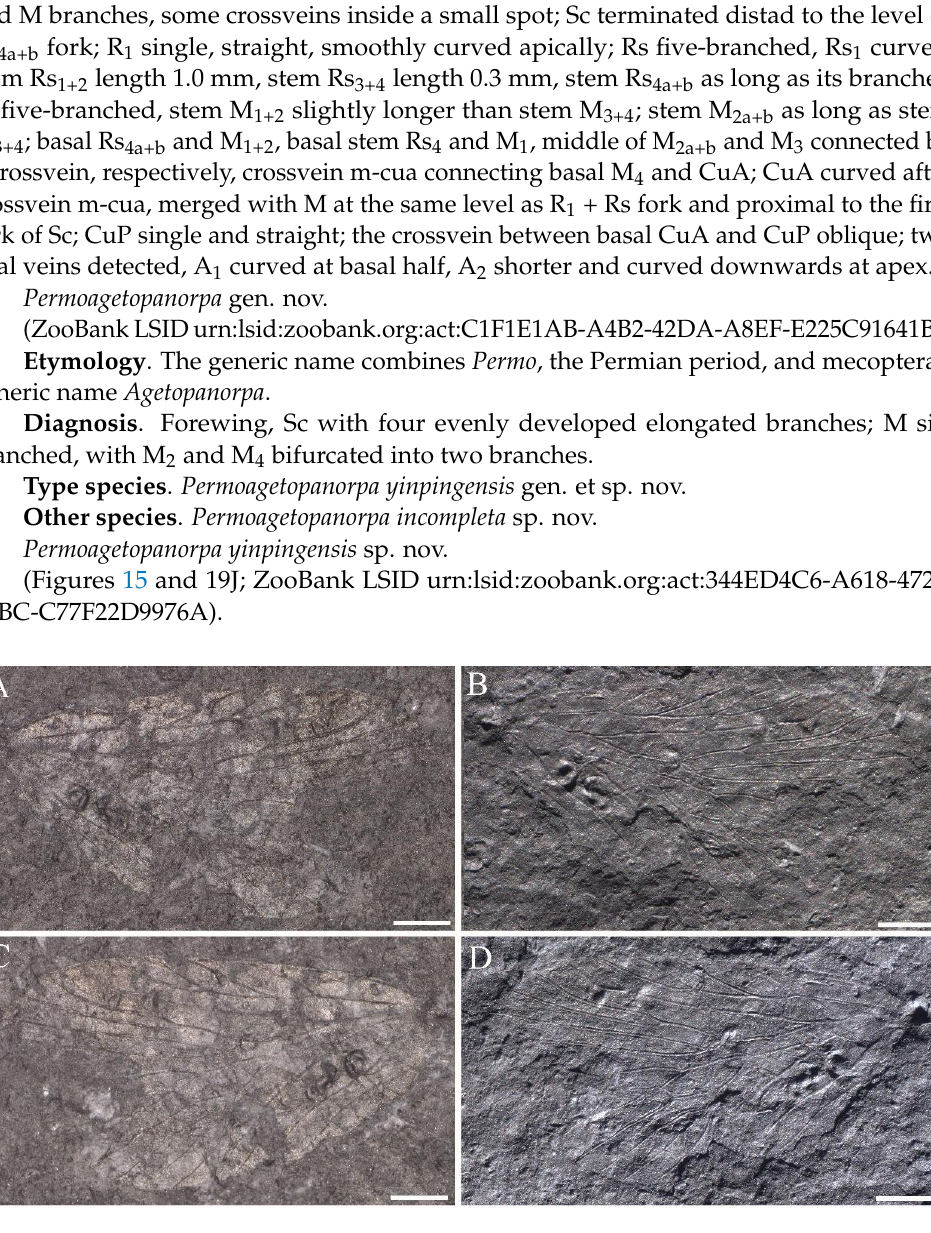
Figure 15. Permoagetopanorpa yinpingensis gen. et sp. nov., NIGP200928 (holotype). ( A , B ) Photographs of part; ( C , D ) Photographs of counterpart; ( A , C ) were taken when specimens were immersed under 70% alcohol in vertical reflected light; ( B , D ) were taken in oblique reflected light. Scale bars represent 1 mm in ( A – D ).